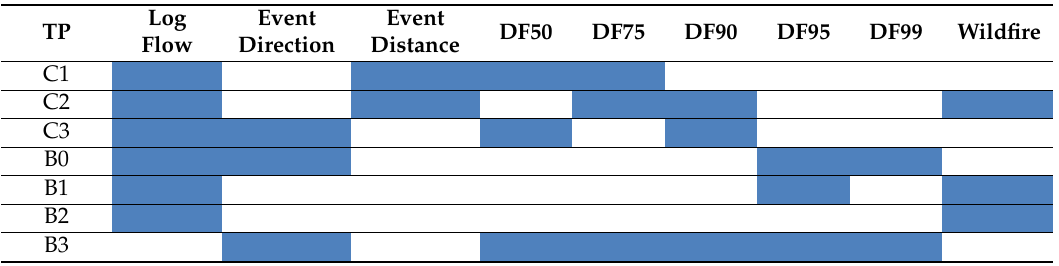
Table 8. Selected predictors for model predicting total phosphorus.